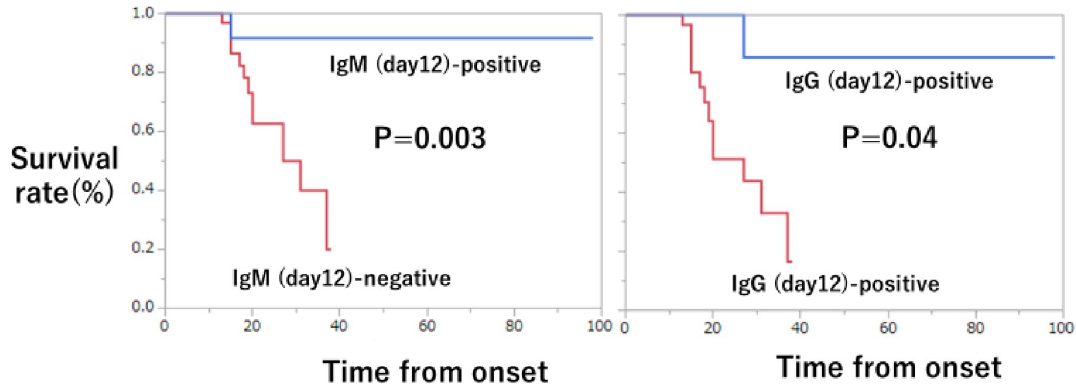
Figure 4. Kaplan–Meier curve on day 12. Kaplan–Meier curves were drawn for antibody-positive and negative cases 12 days after onset with survival as the outcome. IgM/IgG measured values above the cutoff values in Table 2 (IgM ≥ 0.11, IgG ≥ 0.58) were defined as antibody-positive, and those below the cutoff values were defined as antibody-negative. For both, IgM and IgG, the antibody-positive group showed significant differences in survival.